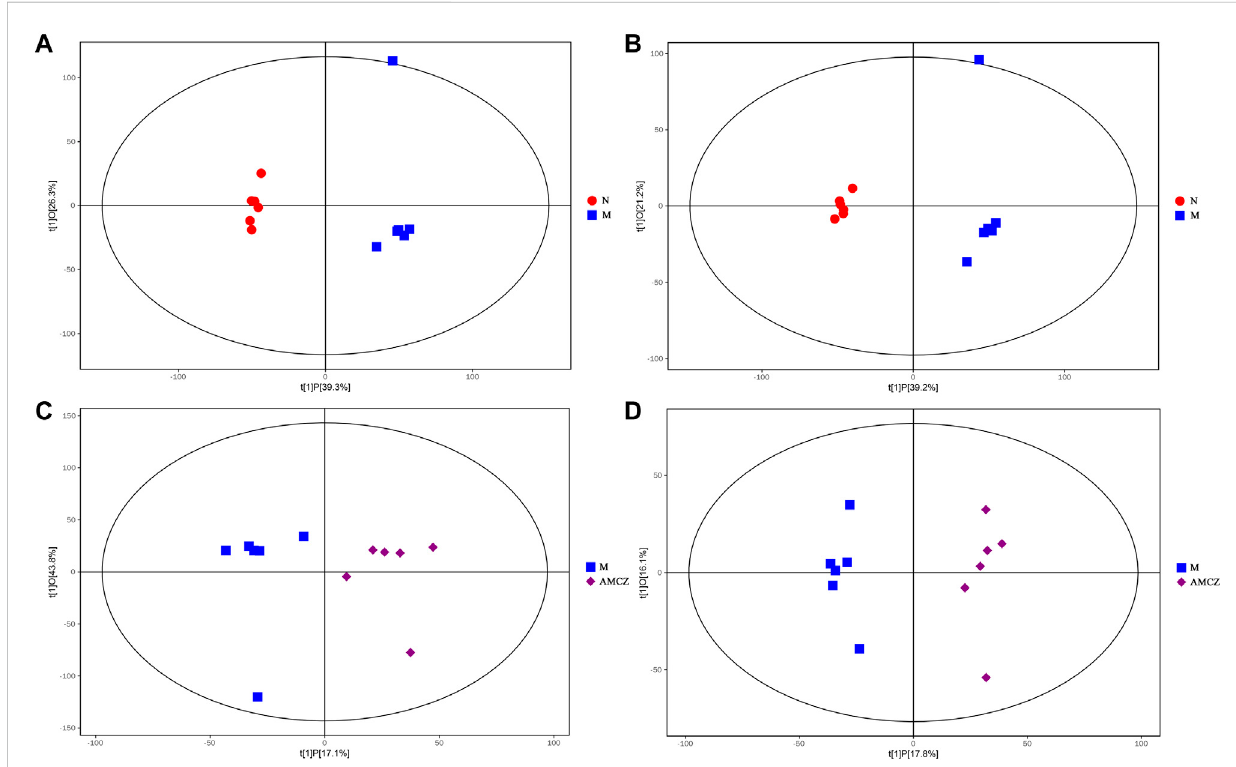
FIGURE 3 OPLS-DA score plot between three groups. OPLS-DA score plot for N versus M in positive (A) and negative (B) ion mode. OPLS-DA score plot for M versus AMCZ in positive (C) and negative (D) ion mode.